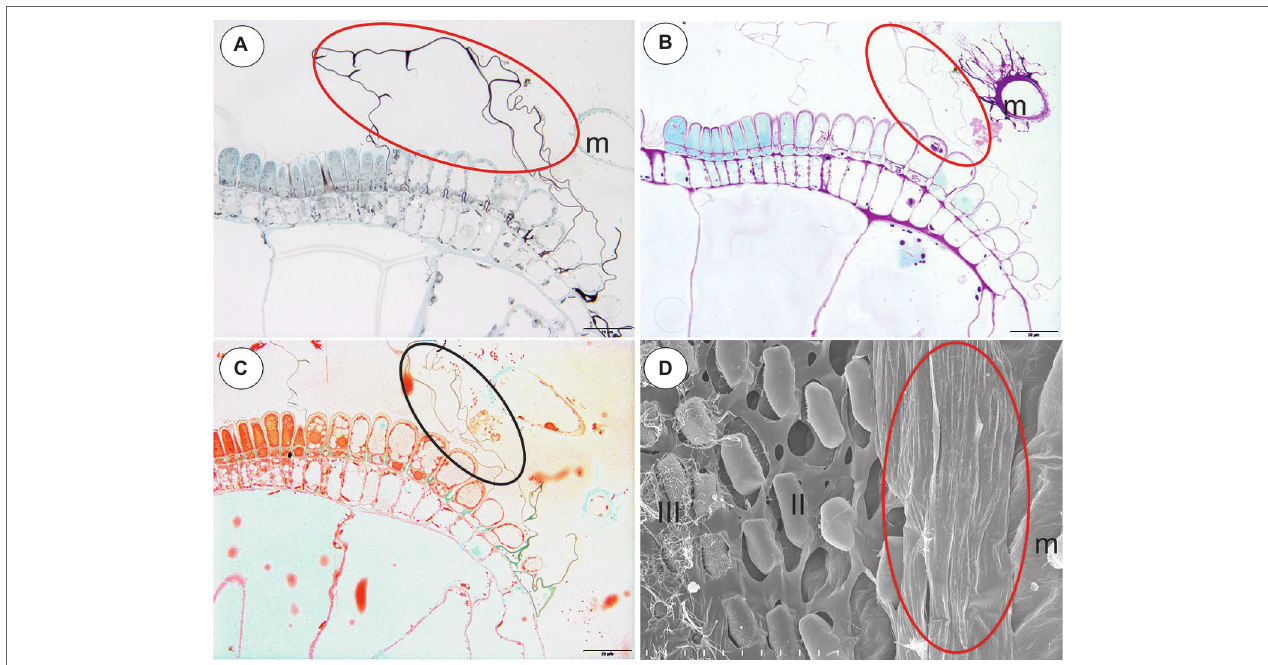
FIGURE 8 | Staining of the pavement epithelium and velum of Utricularia reflexa and U. purpurea . (A) Utricularia reflexa , a semi-thin longitudinal section of the threshold of the external part showing the trichomes that produce the velum (ellipse). The lipid stain SBB was absorbed by the cuticles and lateral walls of the barrier cells; scale bar = 20 μ m. (B) Utricularia reflexa , PAS reaction, note the pink colouration of the velum (ellipse) and the very intensive mucilage production by the stalked trichomes (m); scale bar = 20 μ m. (C) Utricularia reflexa , staining for total proteins noted no proteins in the velum (ellipse) but a positive staining of the bacteria and cytoplasm of the cells of the pavement epithelium trichomes; scale bar = 20 μ m. (D) Utricularia purpurea , a SEM image of the pavement epithelium, note the velum (ellipse), the middle zone (II) and the internal zone (III) with the mucilage trichomes and the sessile mucilage trichomes at the front of the pavement epithelium (m); scale bar = 50 μ